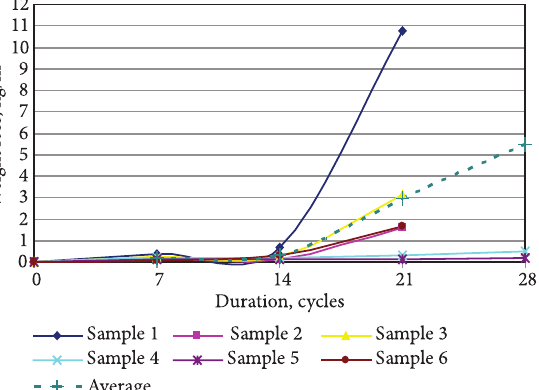
Fig. 5. Weight loss in hardened cement paste with 5 wt% SZ admixture